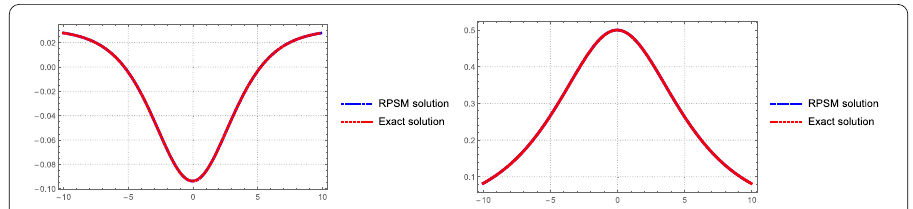
Figure 3 RPSM vs. exact solution for Case I in 2D with λ = 0.5, α = 1